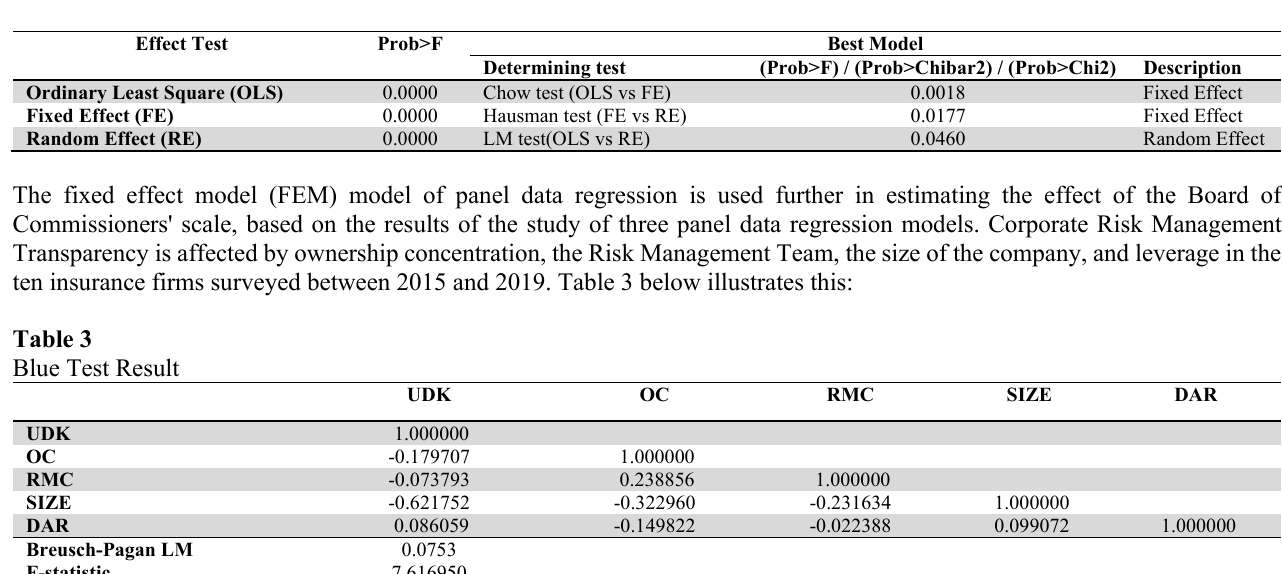
Model Estimation Test Results